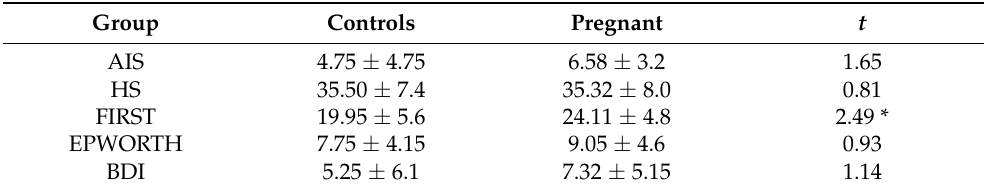
Table 3. Psychosocial characteristics of the study population of pregnant women and non-pregnant controls.